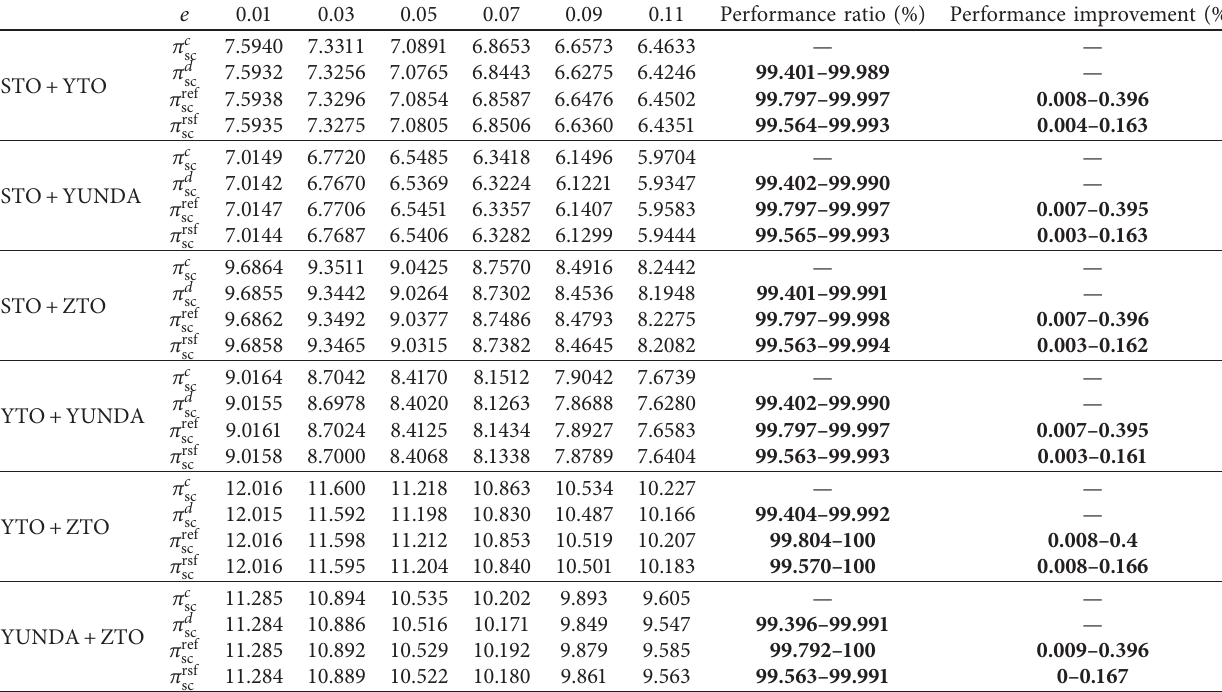
Table 6: Change trends of SC performance on the nonscale economic cost e (unit: 10 18 ).